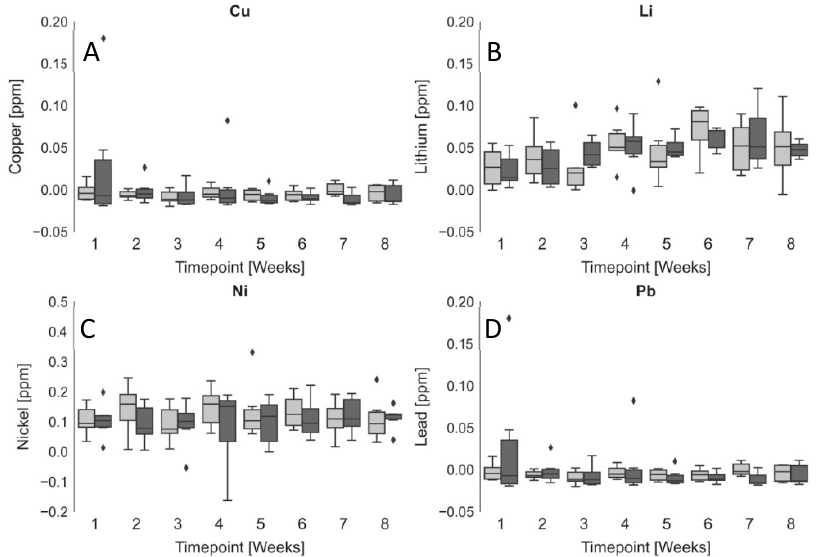
Figure 3. Heavy Metals in Unexposed Sprague Dawley Rat ISF and Blood over 8 weeks. ICP-MS quantification of ( A ) Copper, ( B ) Lithium, ( C ) Nickel, and ( D ) Lead in ISF (light grey) and whole blood (dark grey). Number of animals (N) = 6 (3 female and 3 male). Boxplots show the